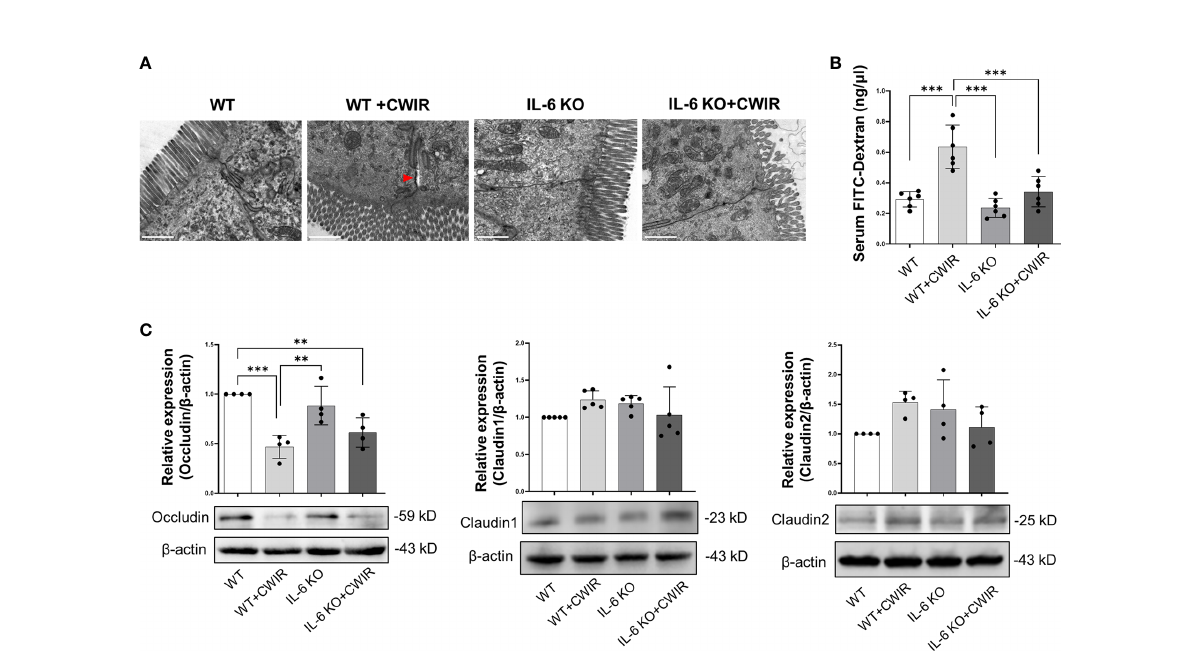
FIGURE 3 CWIR damaged intestinal epithelial tight junctions, which was improved by IL-6 KO. (A), Representative TEM images of jujunal tissues. Red arrow indicates the wider interval between epithelial cells. The scale bar means 10 m m. N=3. (B), Serum FITC-dextran concentration was evaluated in each group. N=6. (C), Relative protein expressions of occludin, claudin 1, and claudin 2 in the jejunum tissues among groups were checked and quanti fi ed. N=4-5, Data analysis was performed by two-way ANOVA with the Tukey post-hoc test. ** p <0.01, *** p